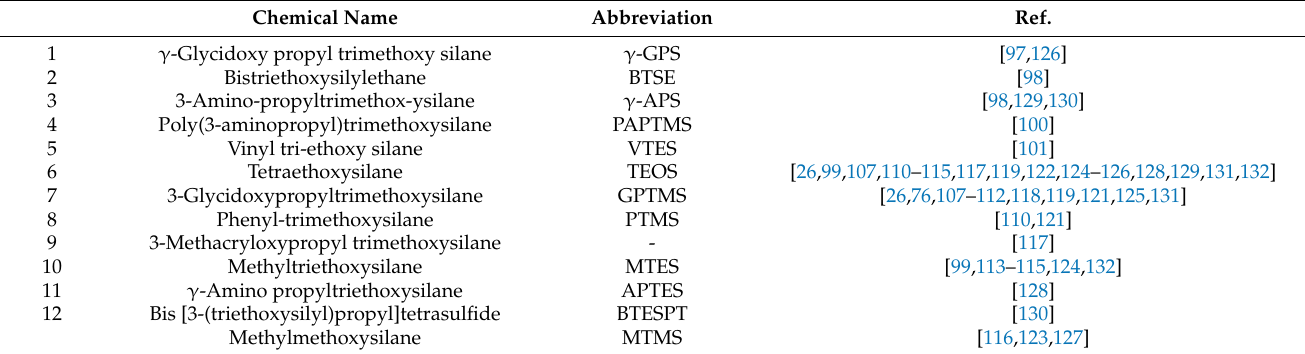
Table 2. The full names and abbreviations of the silane precursors used in the literature cited in Section